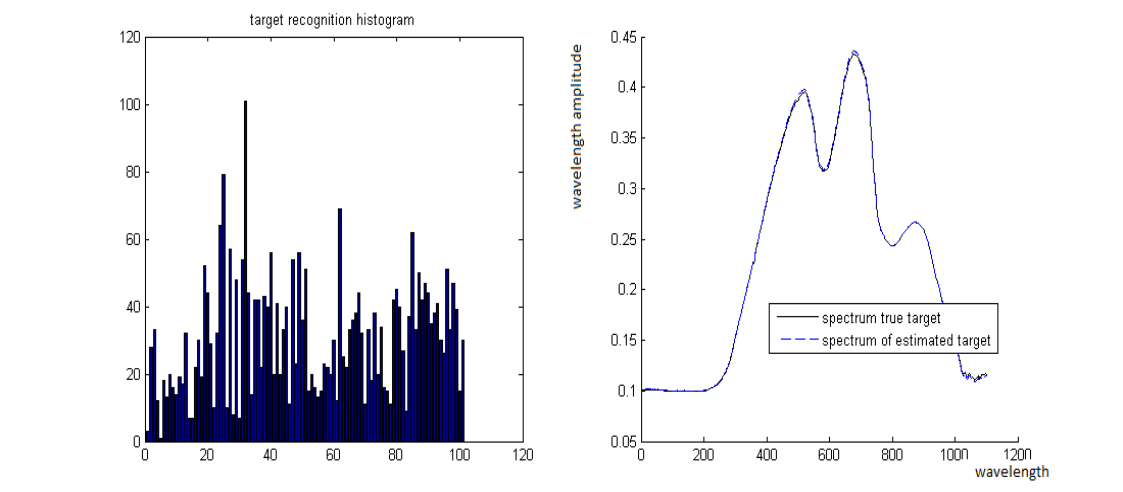
Case 1. True value is t = 0.3 where its estimate is ˆ t = 0.28. Figure 12. Left: The “unmixing histogram” from Definition 5.1. Right: Comparison between T and its estimate ˆ T .